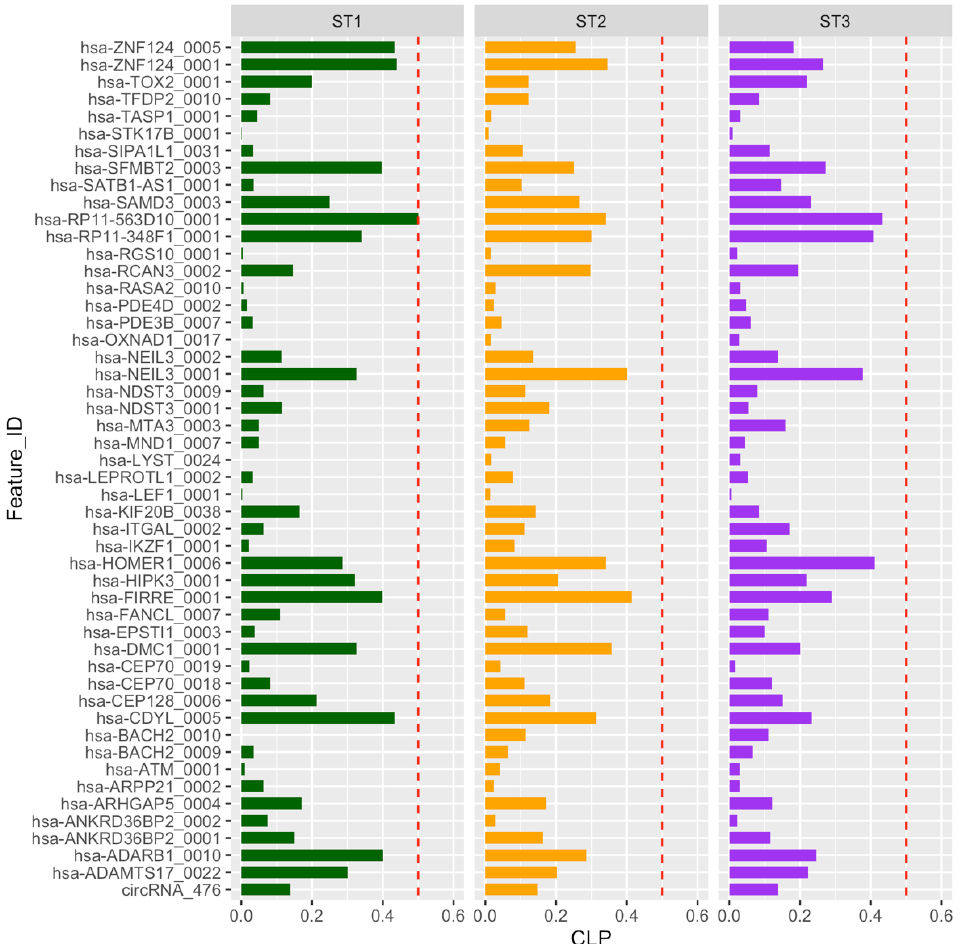
Figure 3. Circular-to-linear expression proportion (CLP) for the circRNAs differentially expressed during thymocyte differentiation in each stage (ST). Red line marks a CLP value of